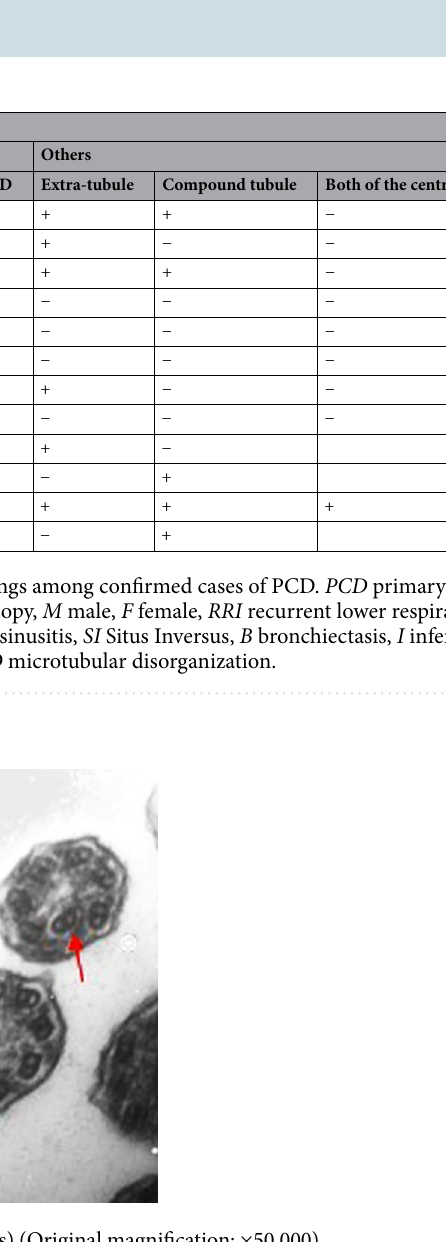
Figure 5. Microtubular disorganization (arrows) (Original magnification: